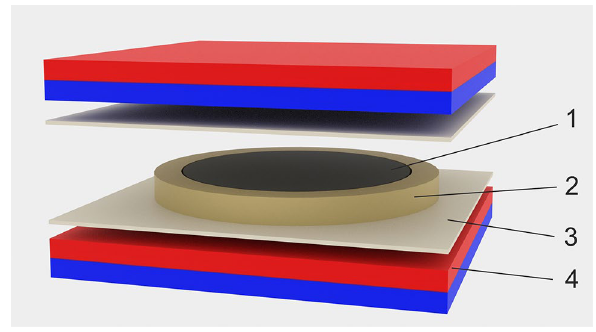
Fig. 4 Fabrication of an MAE sample with anisotropic structure: 1— MAE sample, 2—mold, 3—glass plate, 4—permanent magnet